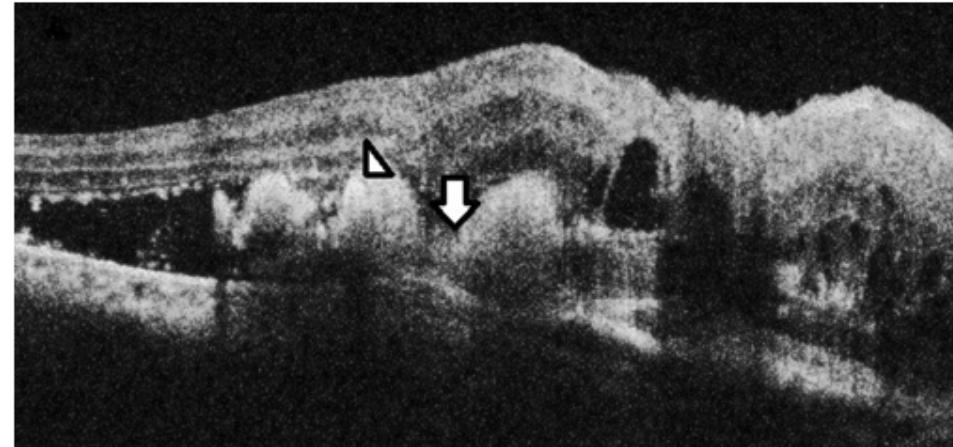
Figure 1: OCT of the right eye showing multiple hemorrhagic PEDs with notch (arrow) and underlying polyps (arrow head) surrounded by SRF